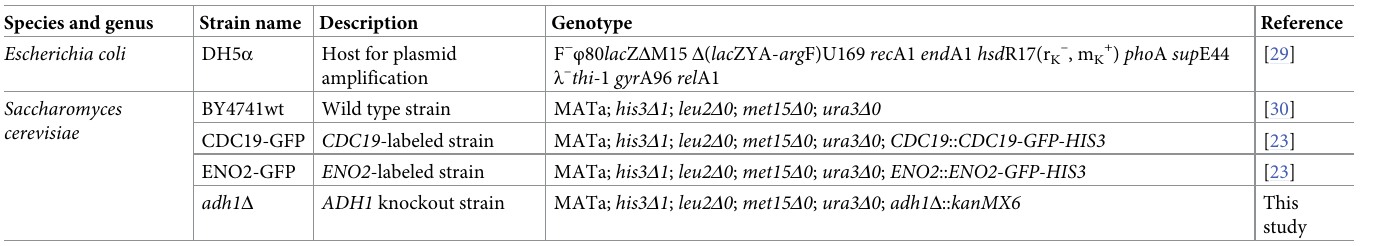
Table 1. Strains used in the present